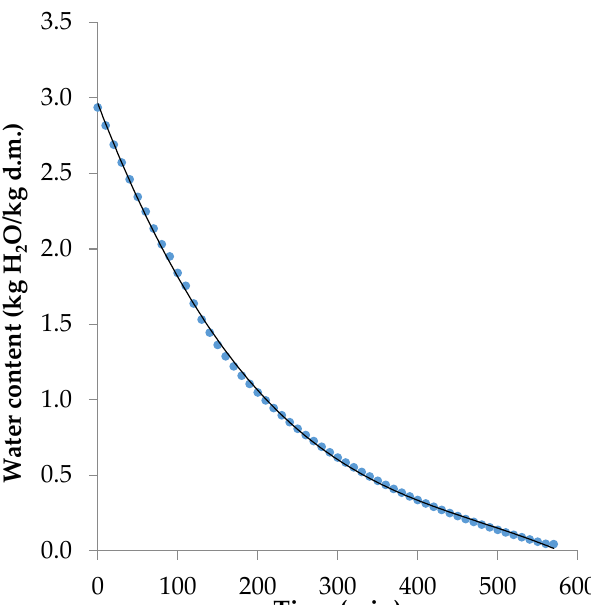
Figure 1. Freeze-drying curve of banana, d.m. (dry mass).